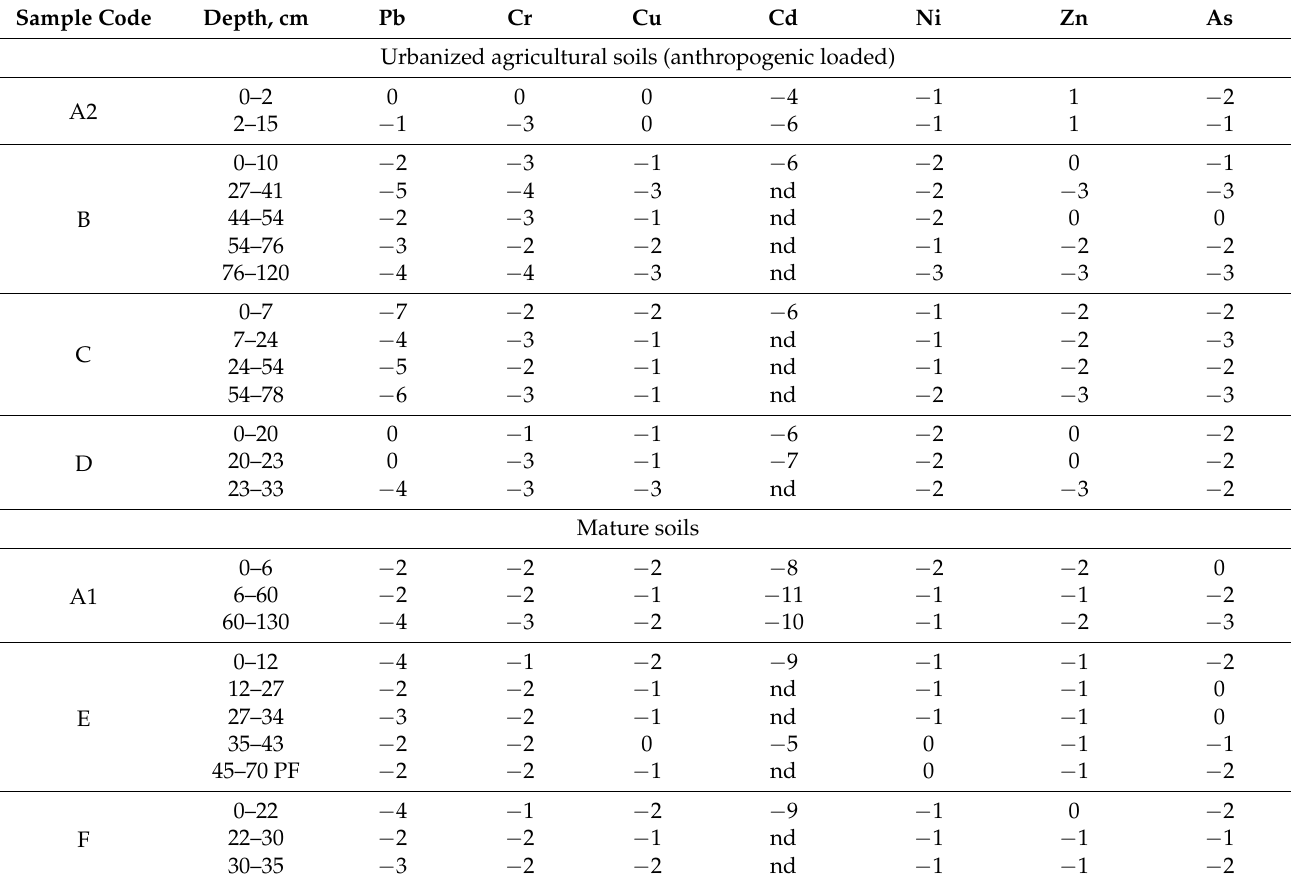
Table 6. Igeo index values for each soil